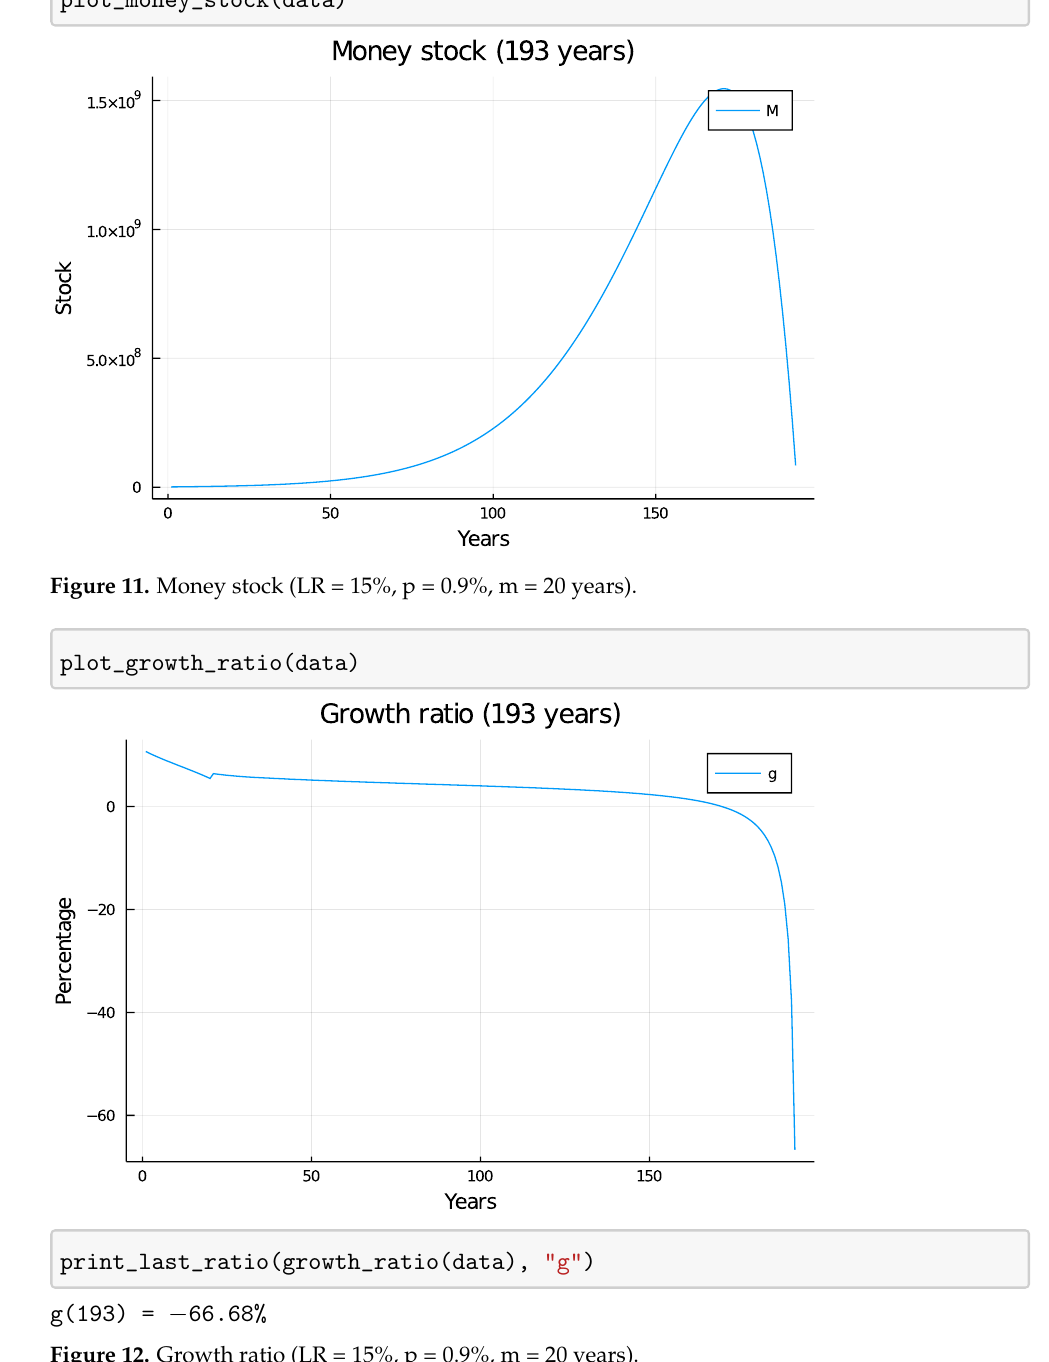
Figure 12. Growth ratio (LR = 15%, p = 0.9%, m = 20